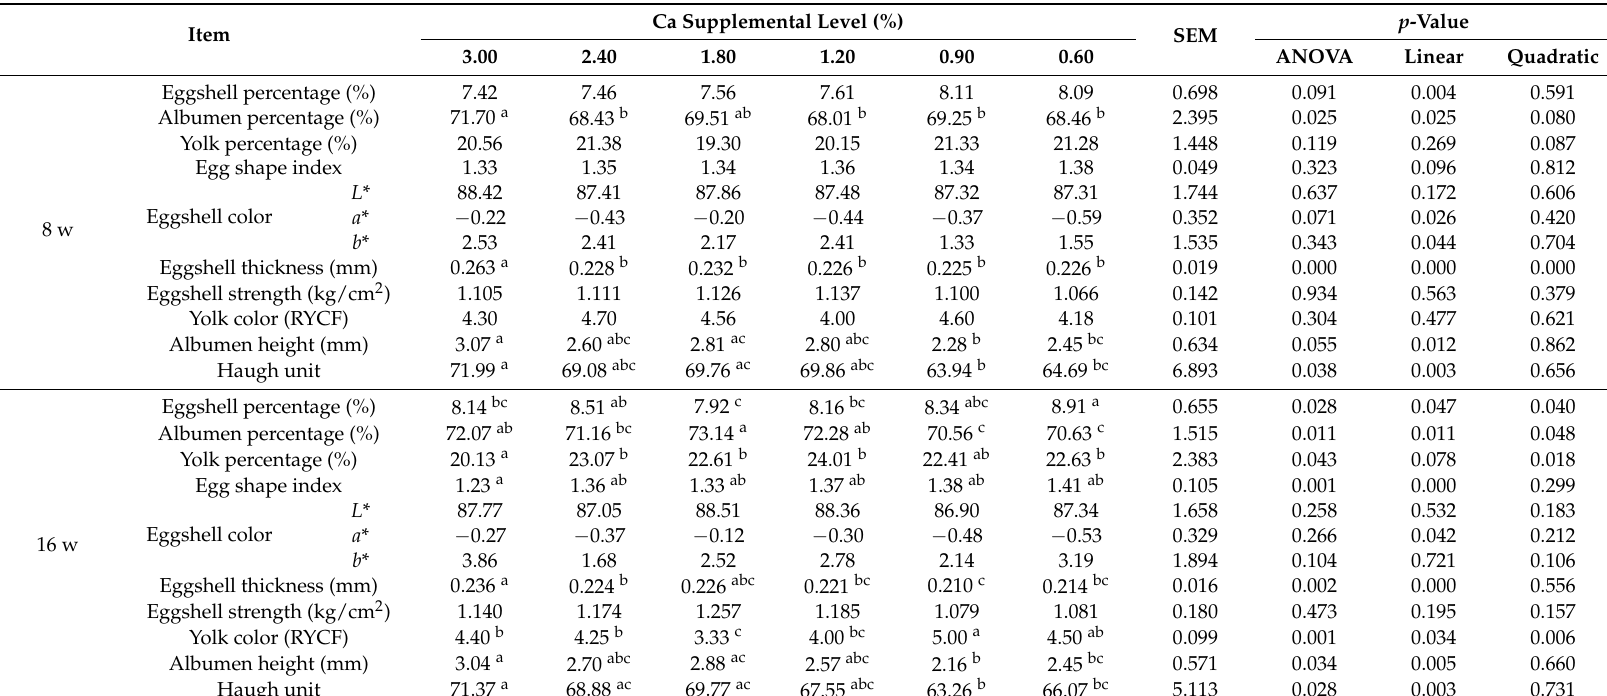
Table 3. The effect of dietary Ca level on egg quality of laying White King